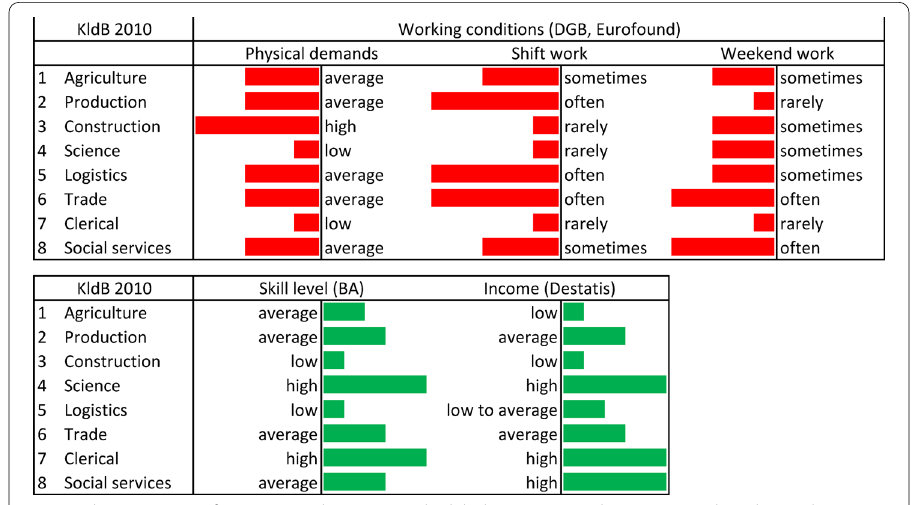
Fig. 3 Characteristics of occupational segments. The labels “average” and “sometimes” describe quality dimension which correspond to the mean values across all occupational categories. A downward deviation from the mean is indicated by “low” and “rarely" and an upward deviation by “high” and “often”. For further explanations see "Appendix" Section A4.1. Source: Eurofound 2017; Institut DGB-Index Gute Arbeit 2012, 2015 ;Sächsisches Staatsministerium für Wirtschaft, Arbeit und Verkehr 2018; Statistik der Bundesagentur für Arbeit 2019c; Statistisches Bundesamt